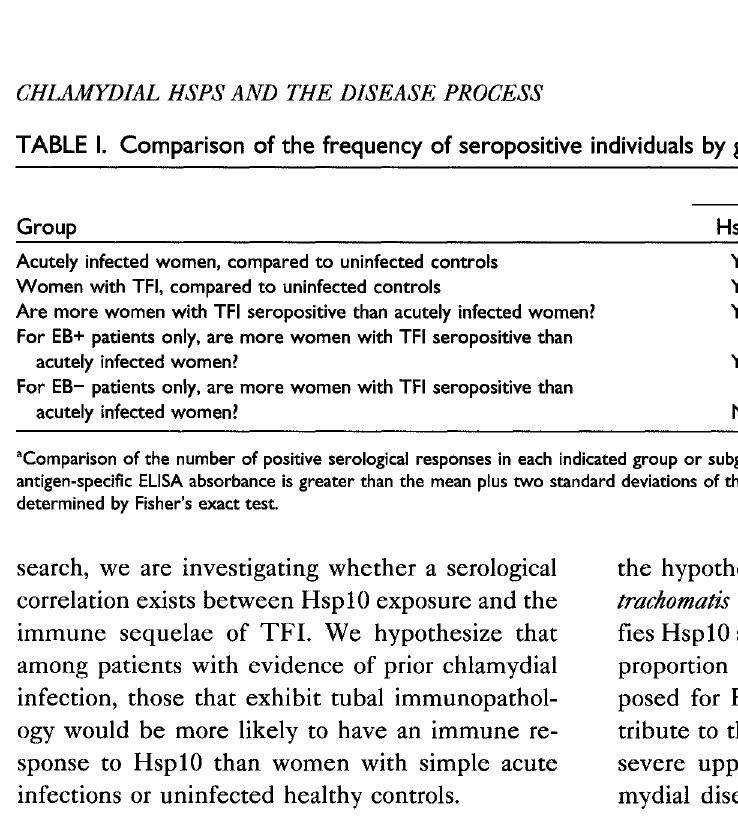
Significantly more women seropositive for Yes Yes Yes Yes Yes Yes Yes Yes No Yes No No No No No